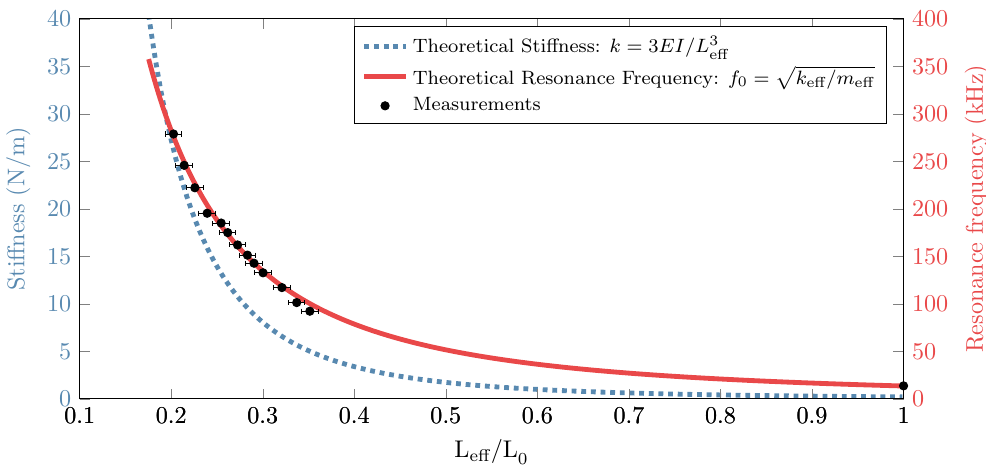
Figure 9. Theoretical stiffness and resonance frequency compared with the measurements as a function of the normalized effective length. The measurement points correspond with the peaks found in Figure 8. The error bars correspond to the measurement uncertainty on the effective length.